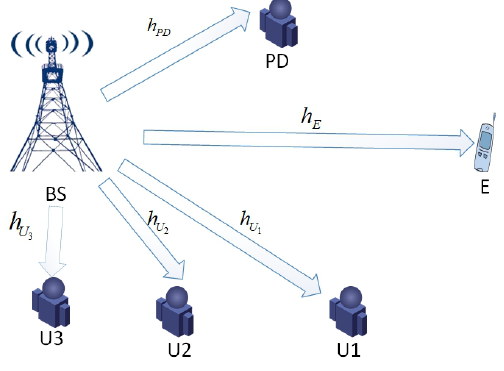
Figure 1. Network